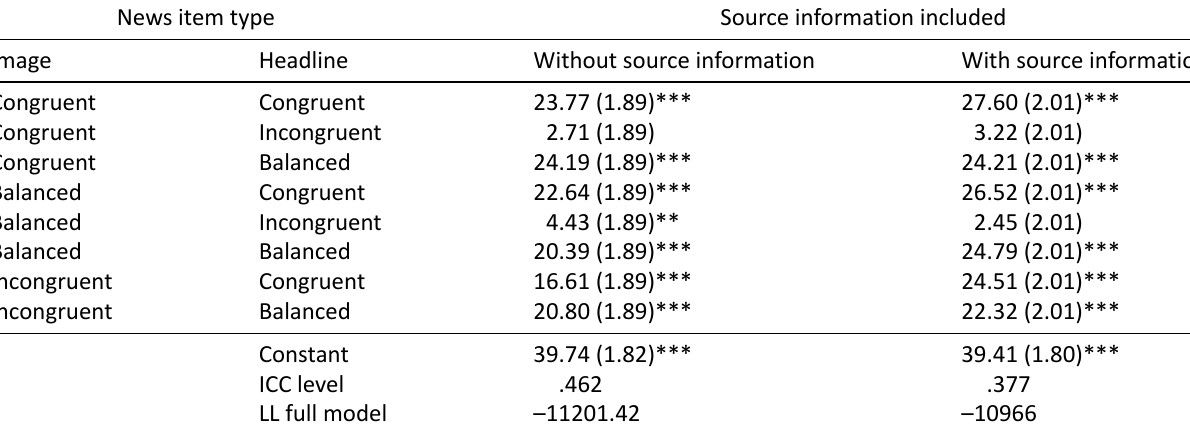
Table A1. Refugees context, multilevel models explaining peoples’ likelihood of viewing a news item, source and no source.